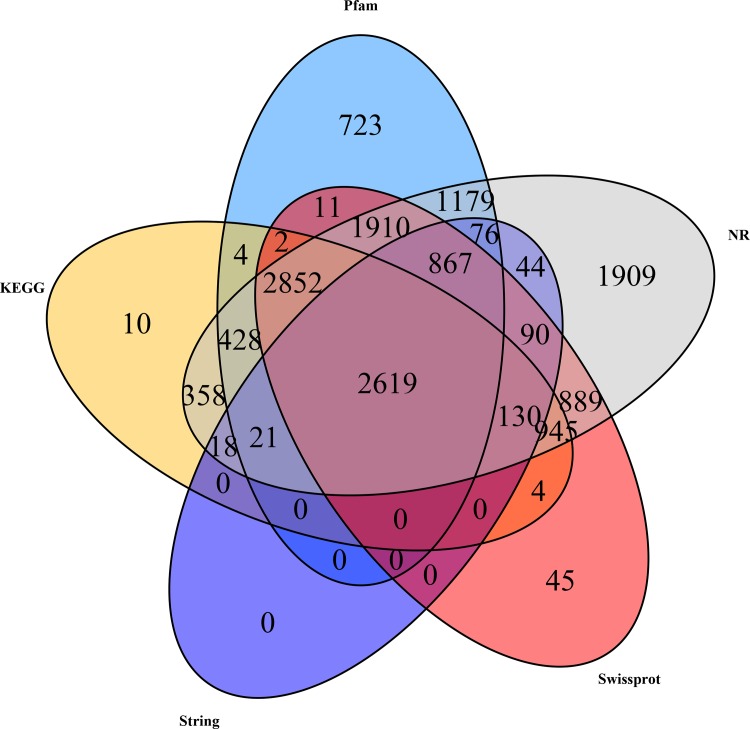
The Venn diagram shows the distribution of unigenes in different databases.The number of the shared unigenes are in the cross area, while the number of the specific unigenes are in the single area.